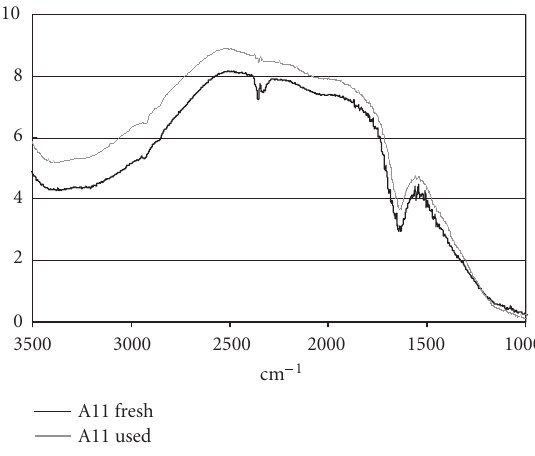
Figure 9: FTIR spectra of fresh and used A11 photocatalysts.